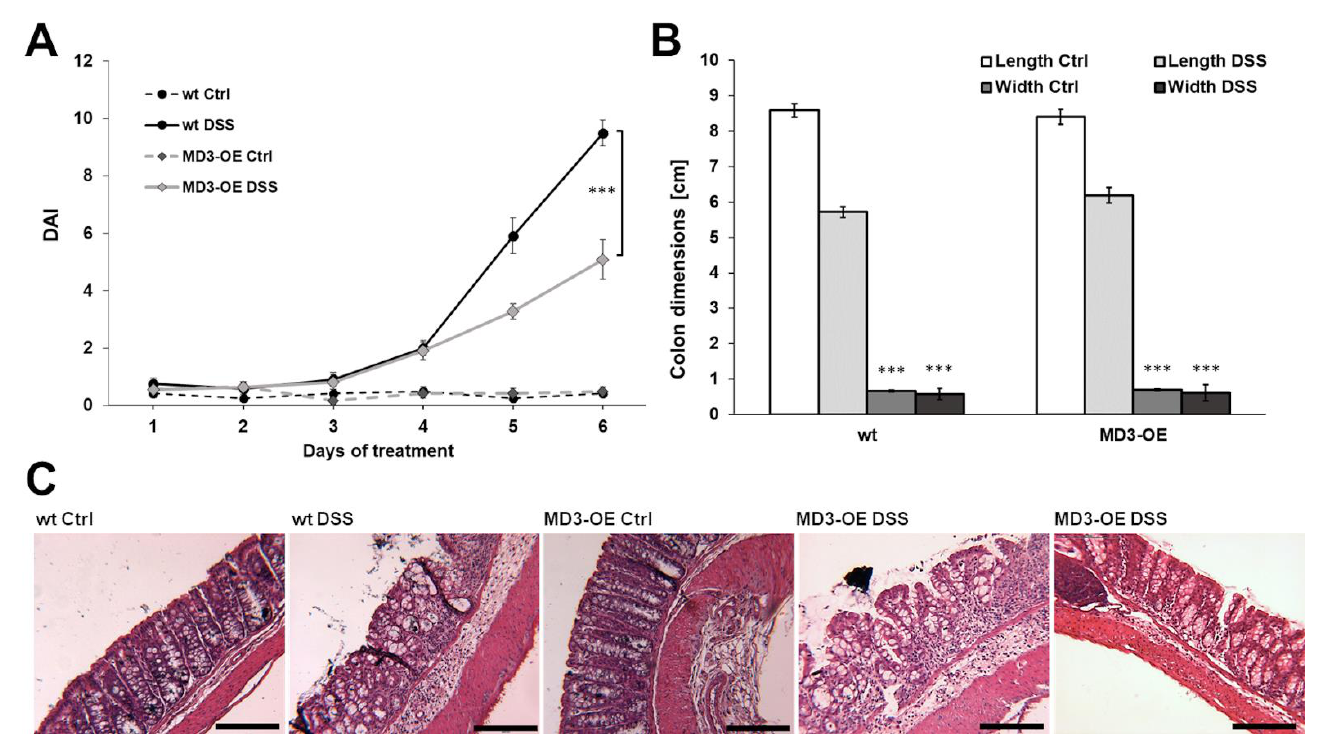
Figure 4. Disease activity index and morphological changes in DSS-induced colitis. ( A ) Disease activity index (DAI) of wildtype (wt) and intestinal MD3-overexpressing mice (MD3-OE) during DSS-induced colitis (*** p < 0.001; n = 11–12). ( B ) Length and width changes in colons of wt and MD3-OE occurred in the same manner during DSS-induced colitis (*** p < 0.001; n = 11–12). ( C ) Representative H&E stainings of colons from wt and MD3-OE mice. Notable was that in about one third of the MD3-OE mice the colon appeared to be impaired only minimally (representative image on the right; bar = 200 µm).